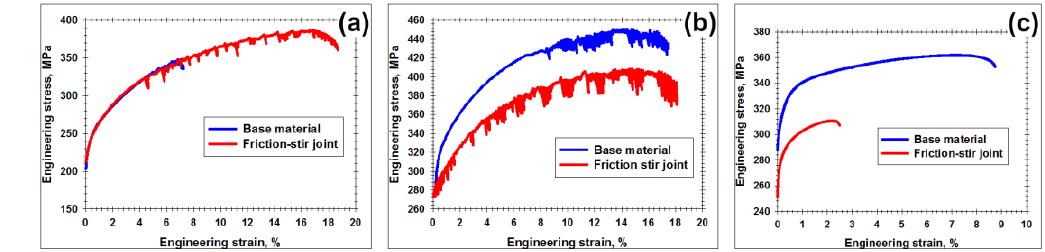
Figure 4. Deformation diagrams comparing tensile behavior of base material and friction-stir joints in ( a ) Al-Mg-Sc alloy with the initial cast condition, ( b ) Al-Mg-Sc alloy with the initial hot-rolled condition, and ( c ) 6061 alloy.